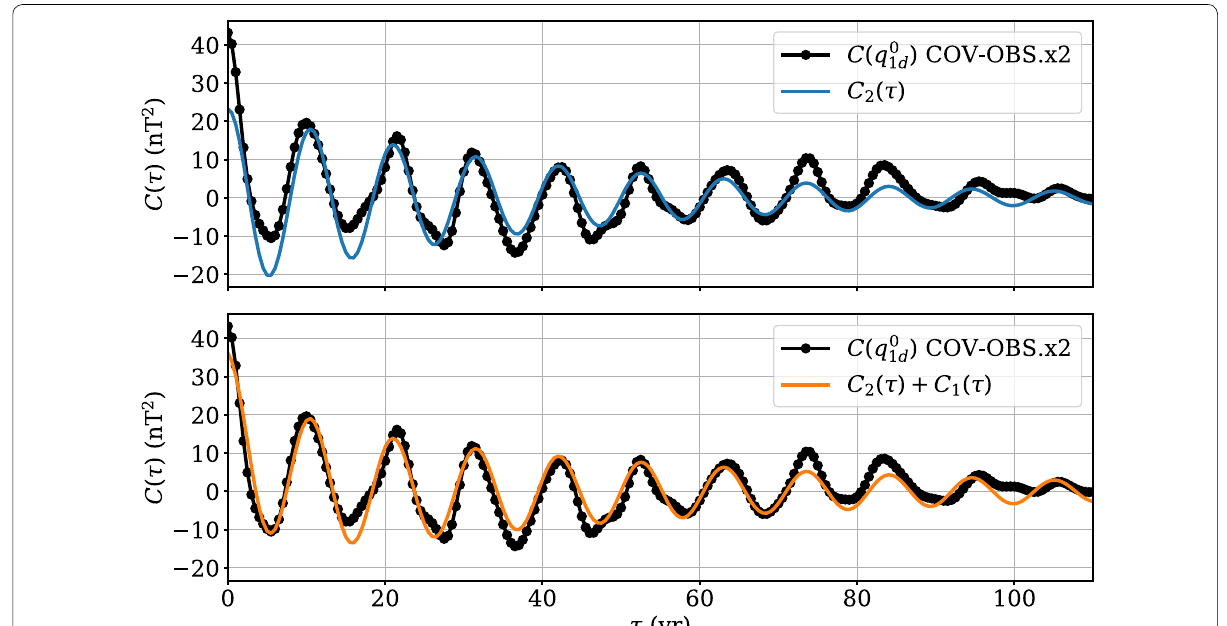
Fig. 11 Auto-correlation function for the external dipole field coefficient q 0 1 d in dipole coordinates, superimposed with the fit obtained with (top) the 3-parameter function C 2 (τ) , and (bottom) a 5-parameter function C 2 (τ) + C 1